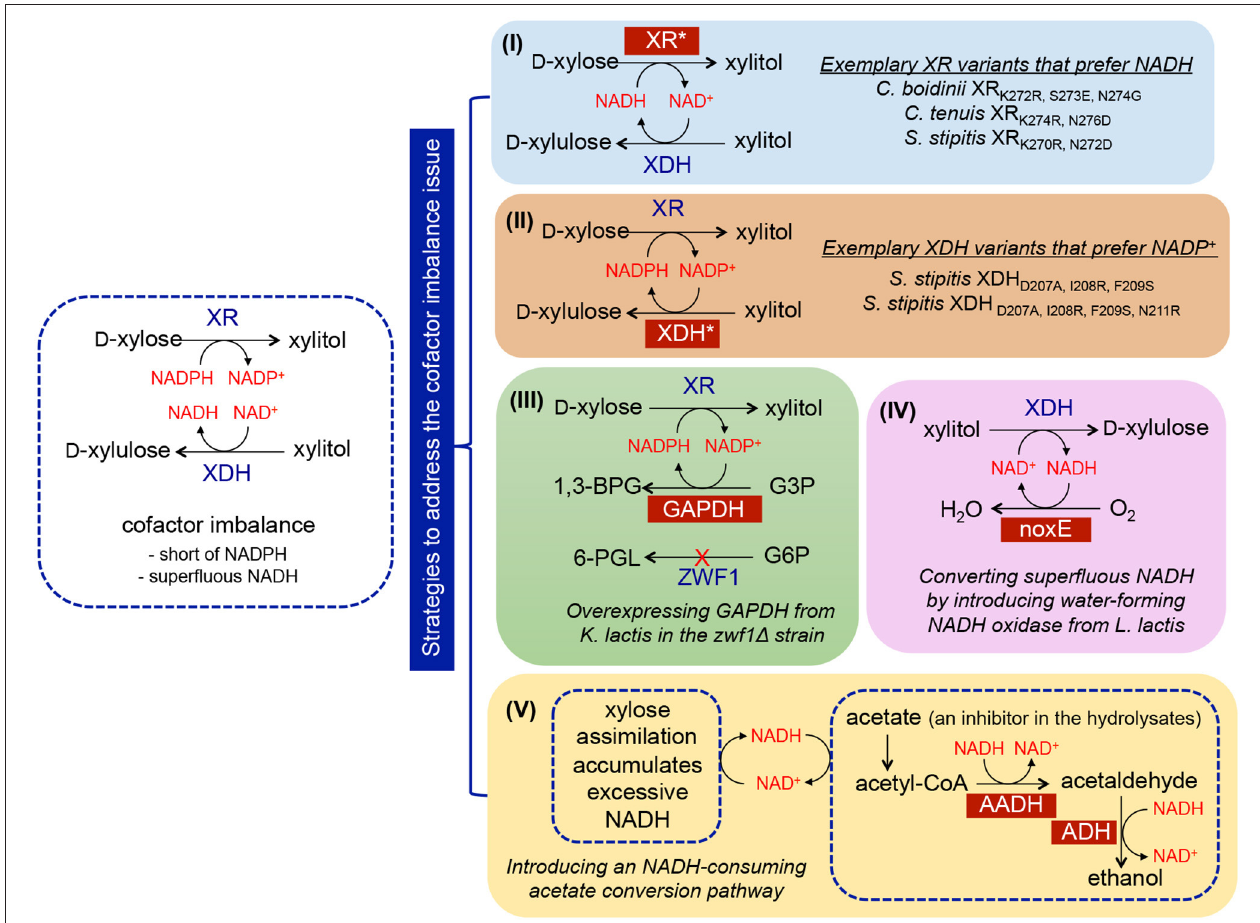
FIGURE 2 | Implementation of metabolic engineering strategies in S. cerevisiae to enhance xylose utilization via ameliorating cofactor imbalance, including (I) discovery of NADH-preferred XR variants; (II) discovery of NADP + -preferred XDH variants; (III) enhancing NADPH regeneration through overexpressing NADP + -dependent GAPDH; (IV) enhancing NAD + regeneration through overexpressing noxE ; (V) improving NAD + regeneration through the integration of acetate-consuming pathway. Abbreviation of metabolites − 1,3-BPG, 1,3-bisphosphoglycerate; 6-PGL, 6-phosphogluconolactone; G6P, glucose-6-phosphate; G3P, glyceraldehyde-3-phosphate. Abbreviation of enzymes— XR , xylose reductase; XDH , xylose dehydrogenase; ZWF , glucose-6-phosphate dehydrogenase; GAPDH , glyceraldehyde-3-phosphate dehydrogenase; noxE , NADH oxidase; AADH , acetylating acetaldehyde dehydrogenase; ADH , alcohol